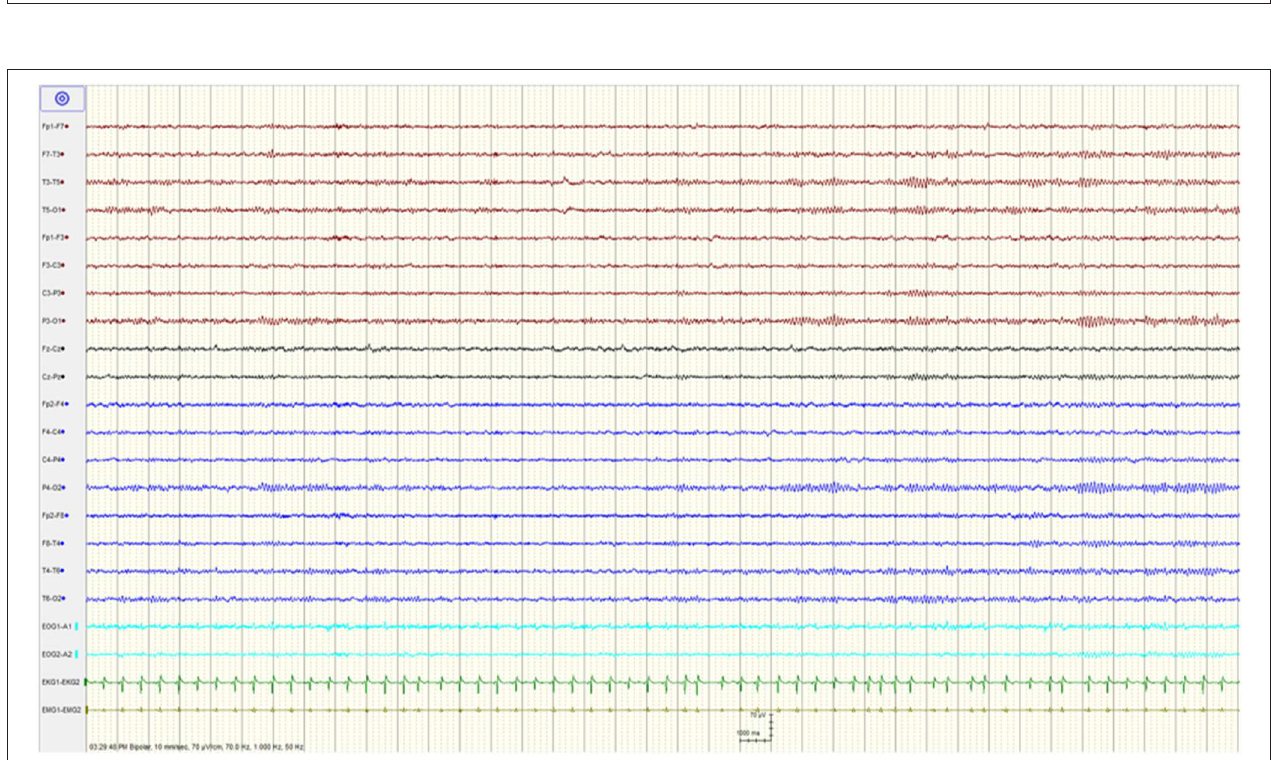
FIGURE 2 | Resolution of the burst suppression pattern and normalization of the EEG after stopping baclofen.